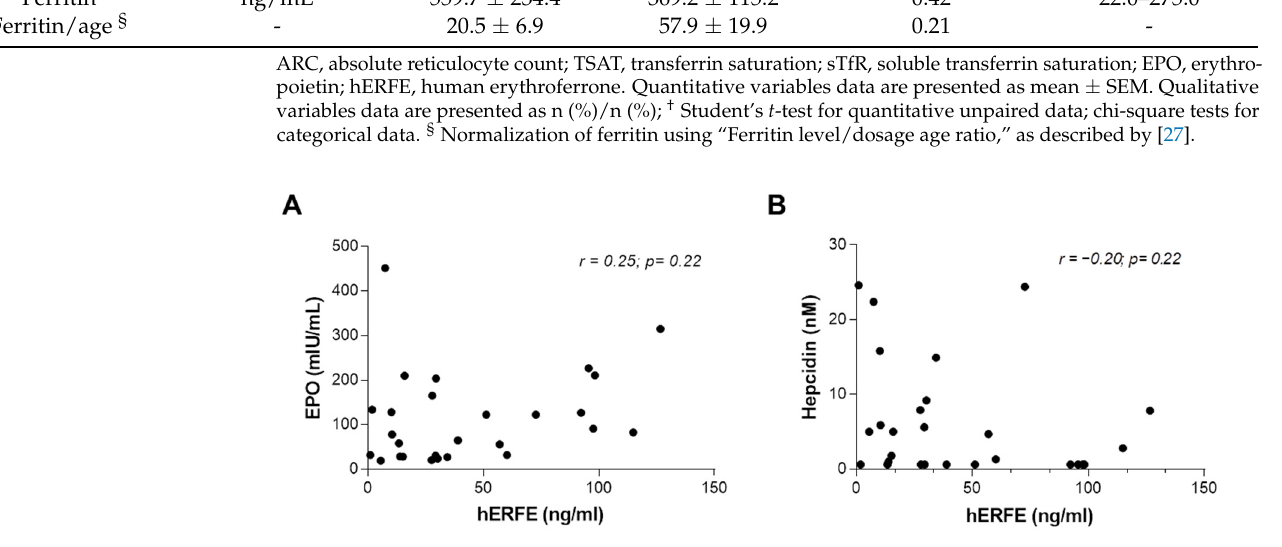
Figure 1. Correlation analysis between ERFE, EPO, and hepcidin levels. The graphs show the correlation analysis between ERFE and EPO levels ( A ) and between hepcidin and ERFE levels ( B ) in plasma samples from 28 CDA II enrolled in the study (r and p -value by Pearson correlation analysis).